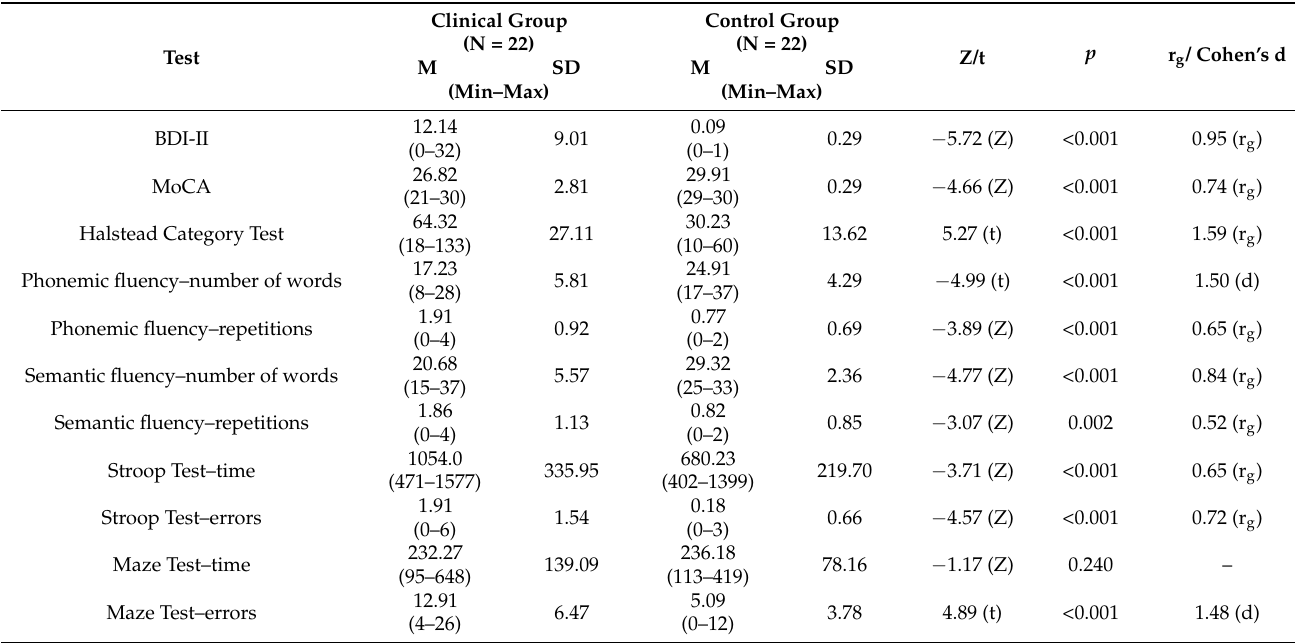
Table 1. Descriptive statistics of the results and comparison of the variables investigated in the group of patients with RRMS and the control group.